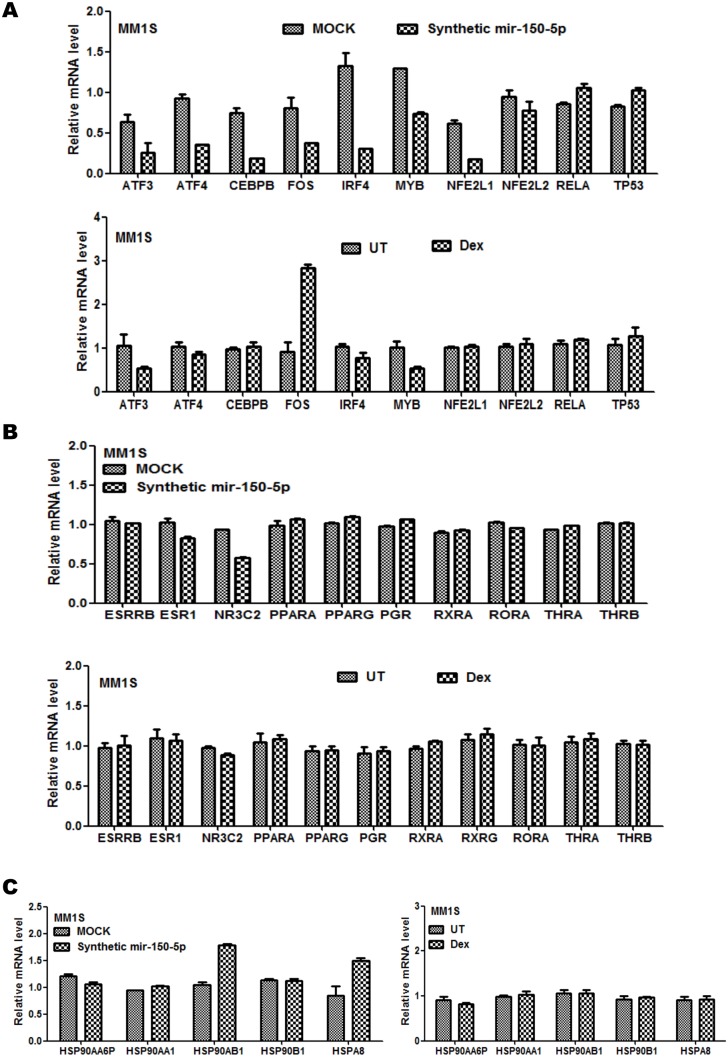
Mir-150-5p transfection is associated with complex regulation of transcription factors, hormone receptors and chaperones.Illumina BeadChip Gene Expression results of transcription factors (A), nuclear hormone receptors (B), and chaperones (C), are presented as bargraphs, reflecting mean of gene expression fold change from three independent experiments of MM1S, treated for 72 h with 1 µM Dex versus control setup (UT), or else of MM1S cells transfected for 72 h with synthetic mir-150-5p versus mock transfection.